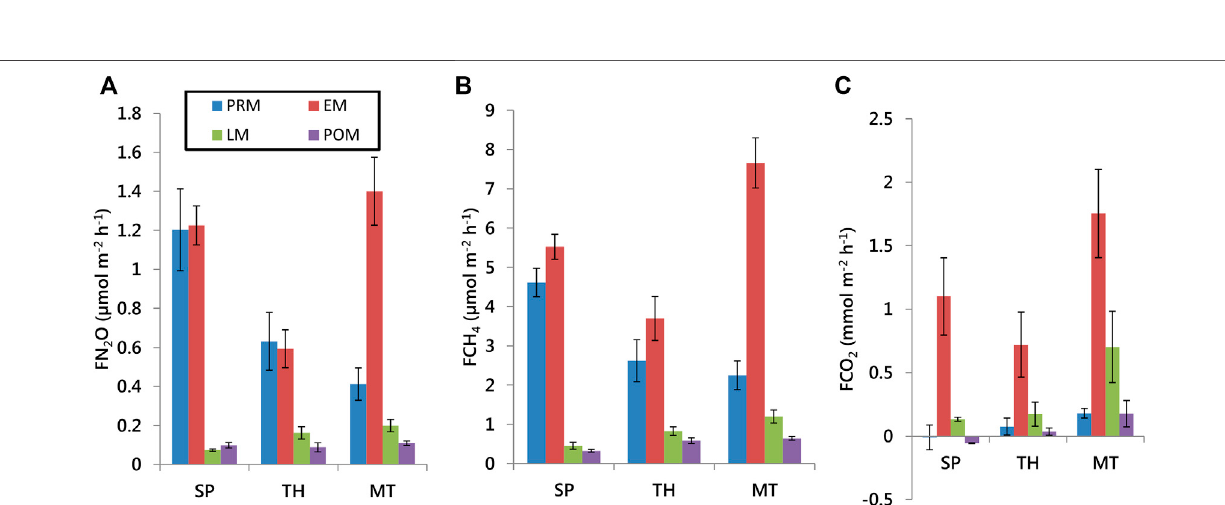
Frontiers in Earth Science |